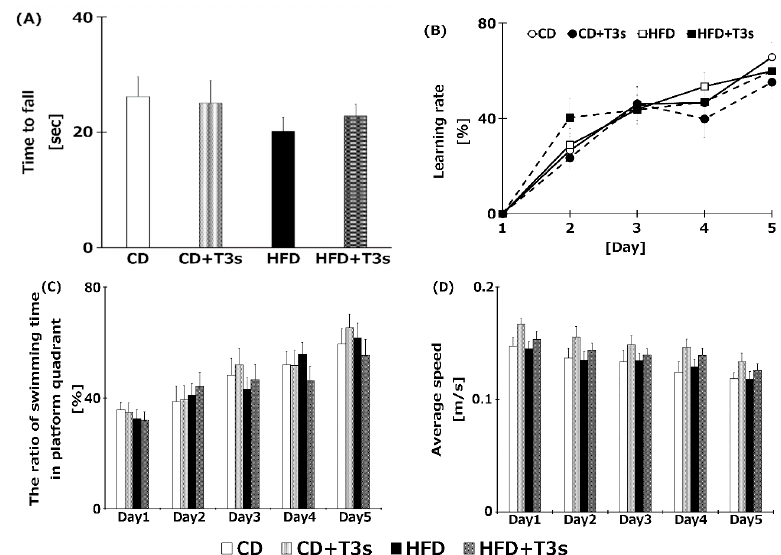
Figure 4. Assessment of cognitive function of each treatment group using the Rota rod test ( A ), the Morris water maze test ( B ), ratio of swimming time in platform quadrant ( C ), and average swimming speed ( D ). Learning ability was calculated from the goal time of each mouse. CD = Control diet ( n = 14), CD + T3s = CD + T3 mix ( n = 16), HFD = high-fat diet ( n = 15), HFD + T3s = high-fat diet + T3 mix ( n = 13). Data are expressed as mean ± SE.